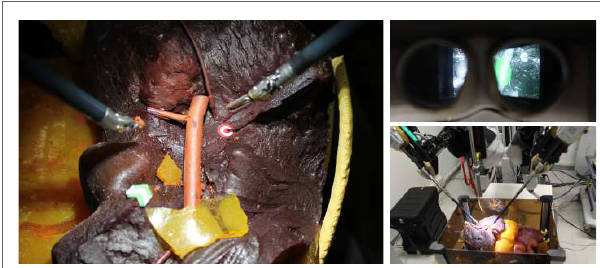
FigUre 10 | experimental setup . On the left, the operating field characterized by a liver phantom and a delicate vessel, which is the safety area to be preserved from injuries during surgery. The green arrow and the red target represent, respectively, the starting and the ending point of the task executed by the subjects during the experimental trials. On the top-right, the 3D visor showing the augmented images. On the bottom-right, the da Vinci robotic arms performing the task, tele-operated from the console by the